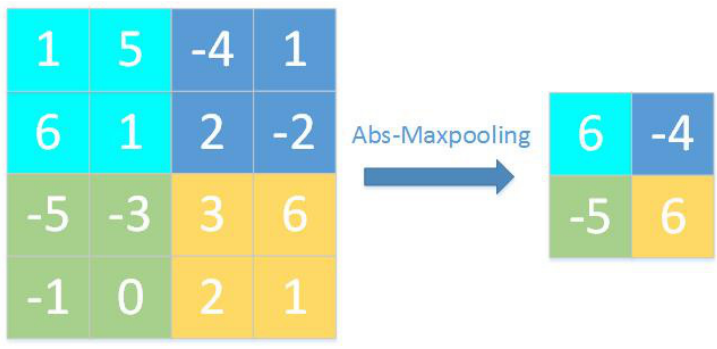
Figure 1. ResNet residual block and improved binarized residual block.